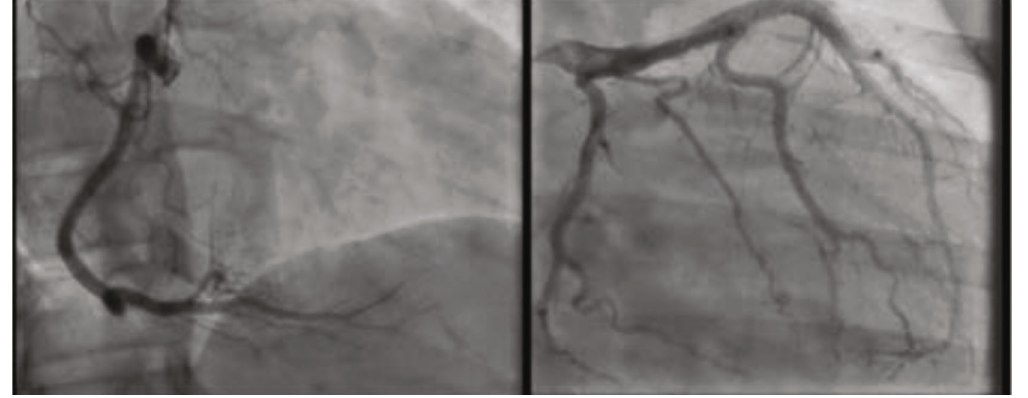
Figure 2: Left heart catheterization demonstrating angiographically normal coronary arteries.